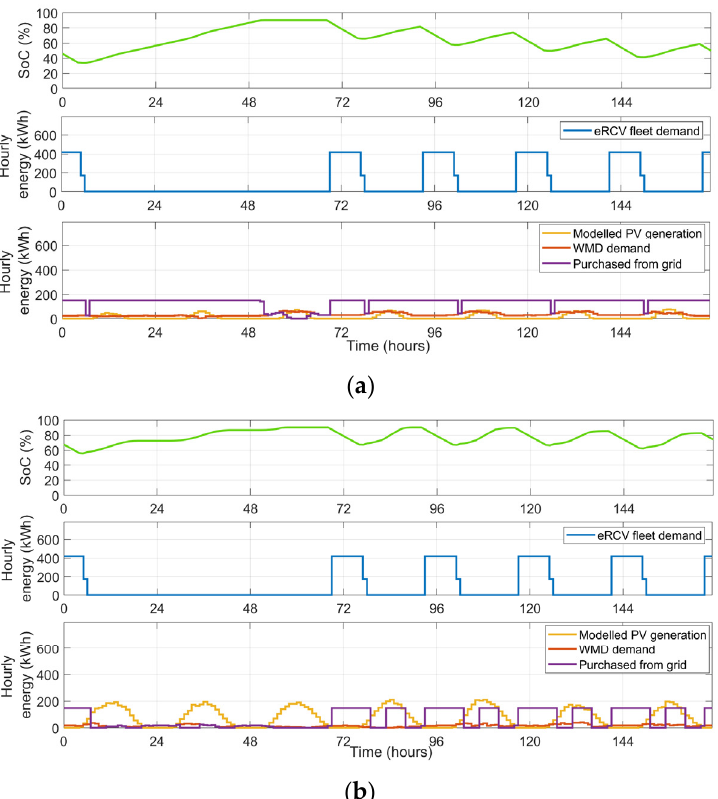
Figure 15. Hourly energy distribution for scenario 3 with a BESS capacity of 10 MWh in a week in ( a ) February and ( b ) July.